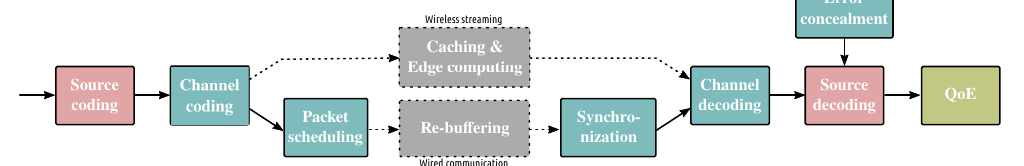
Figure 1. Multimedia transmission